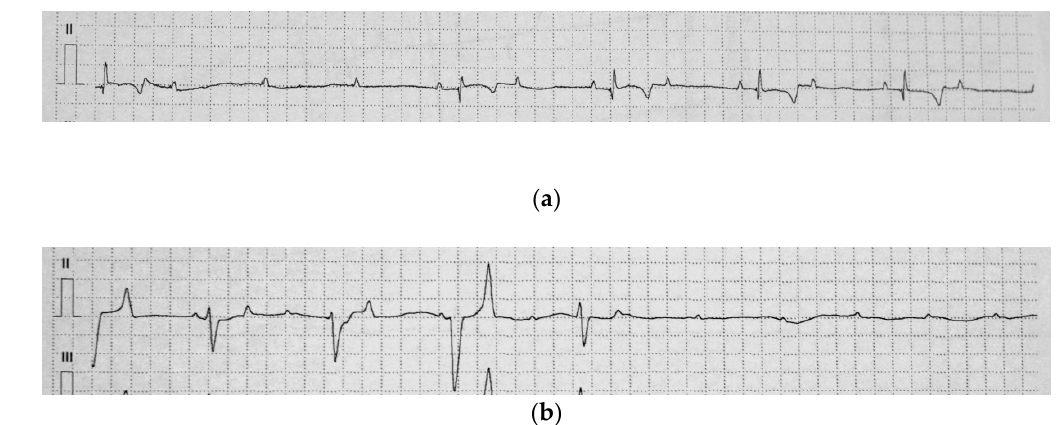
Figure 1. Base apex electrocardiogram of the jenny ( a ) A high-grade, second-degree atrioventricular (AV) block. Three consecutive P-waves are not followed by a QRS complex ( b ) A complete AV block with an independent atrial and ventricular rate. The tracing shows polymorphic QRS complexes and the interruption of the ventricular escape rhythm (25 mm/s, 1 cm/mV).